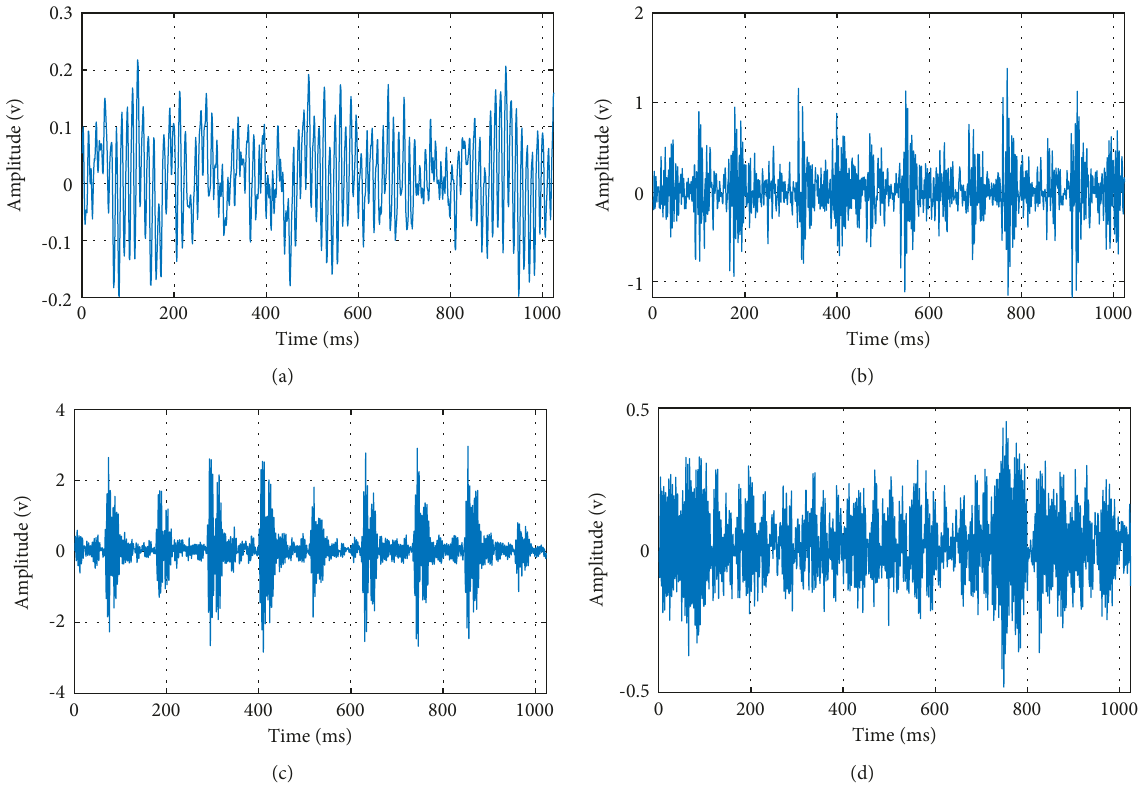
Figure 4: Vibration signals of bearings with different types. (a) NO. (b) IF. (c) OF. (d) BF.